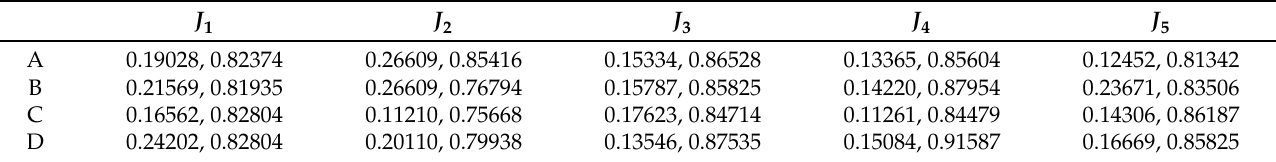
Table 2. Weighted decision matrix.